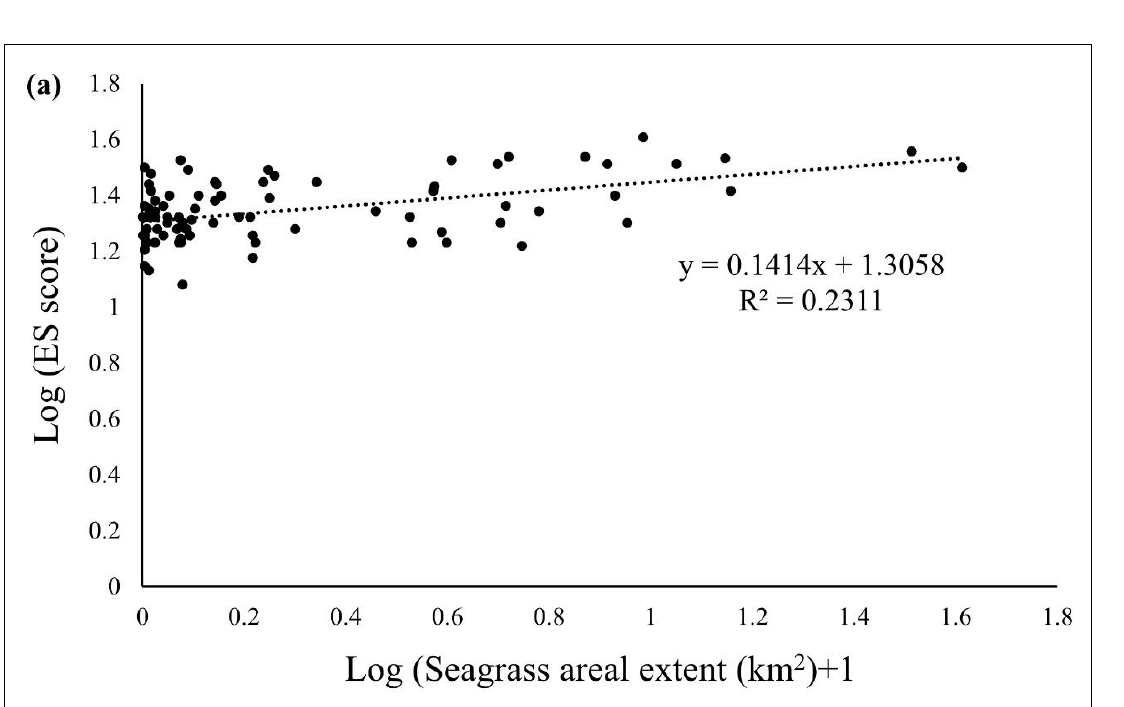
ability (from 82 sites). The sites are ranked 1 to 10, from the highest to the lowest final assessment score.